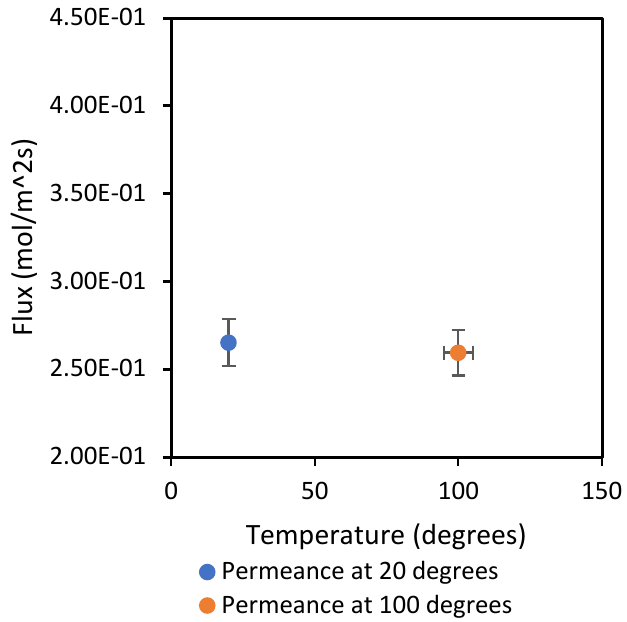
Figure 7. Effect of temperature on flux for CO 2 gas through 15 nm membrane at 1 bar.